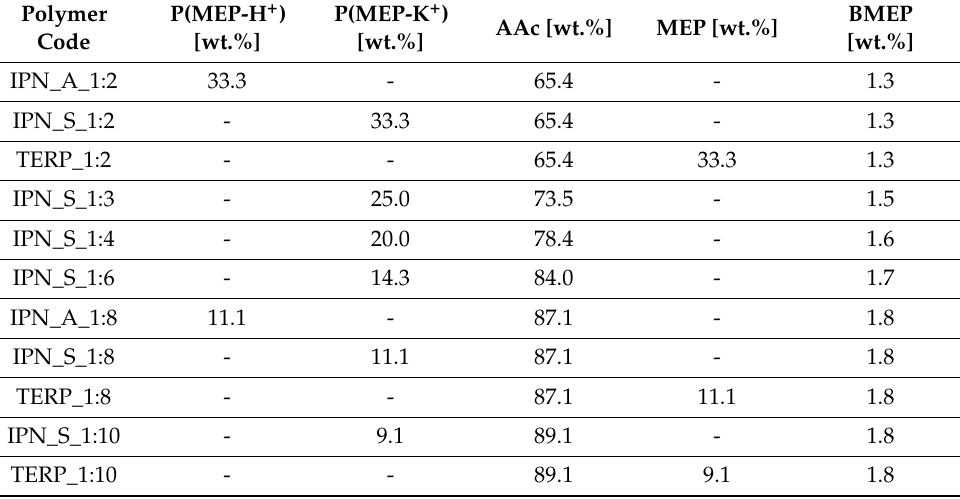
Table 1. Polymer composition. The amount of initiator and solvent was kept constant (1 wt.% in reference to monomer weight and 1:1 water:monomer weight ratio,